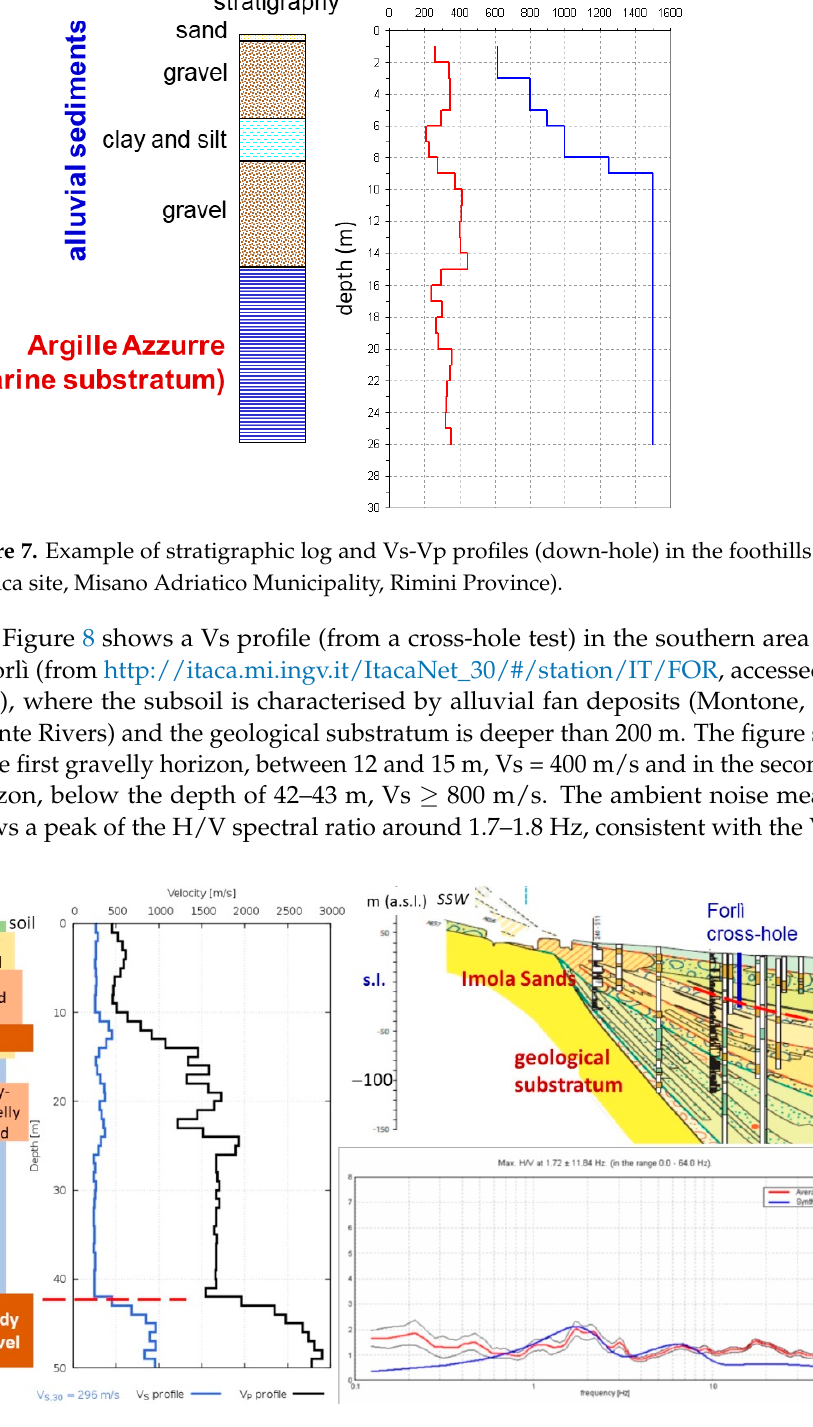
Figure 8. Stratigraphic log, Vs-Vp profiles (cross-hole, from http://itaca.mi.ingv.it/ItacaNet_30/#/station/IT/FOR, with modifications, accessed on 1 July 2021) and ambient noise measurement (from seismic microzonation, Forlì Municipality) in the Forlì station of the National Accelerometric Network; geological cross-section from CARG 1:50,000, sheet n. 240 “Ravenna”.